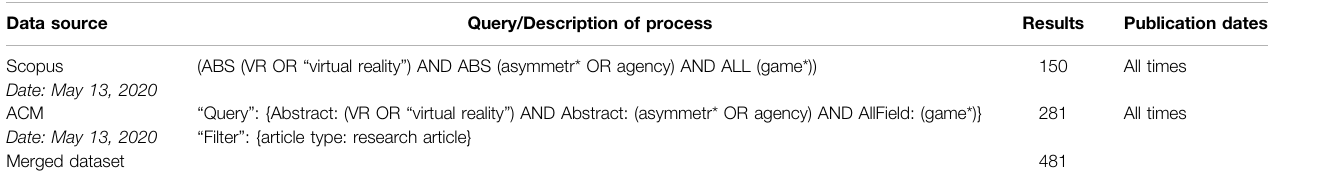
TABLE 1 | Data sources, queries, dates, numbers and publication dates of results. Data source Query/Description of